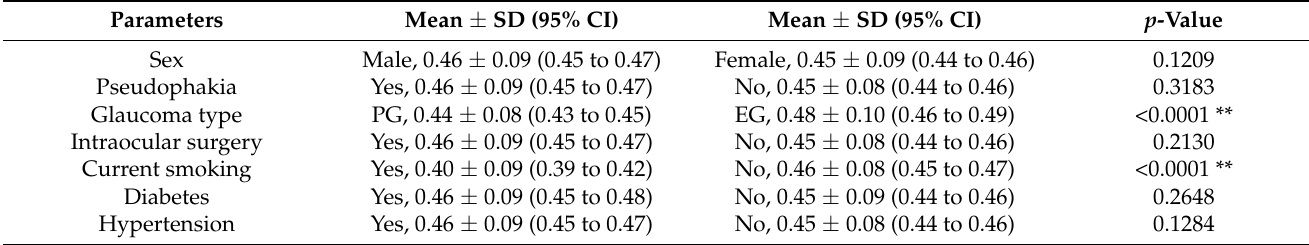
Table 5. Possible association among AGEs and various categorical